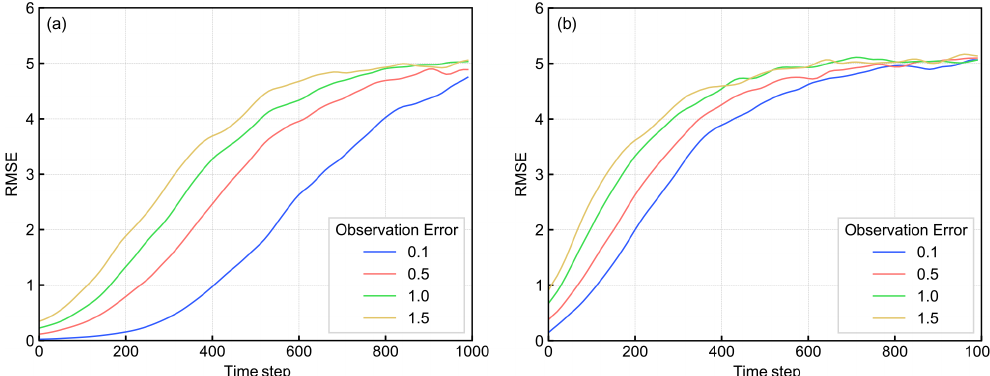
Figure 6. The mRMSE time series of the predictions of (a) LETKF-Ext and (b) RC-Obs with noisy observation. Each color corresponds to the observation error indicated by the legend.